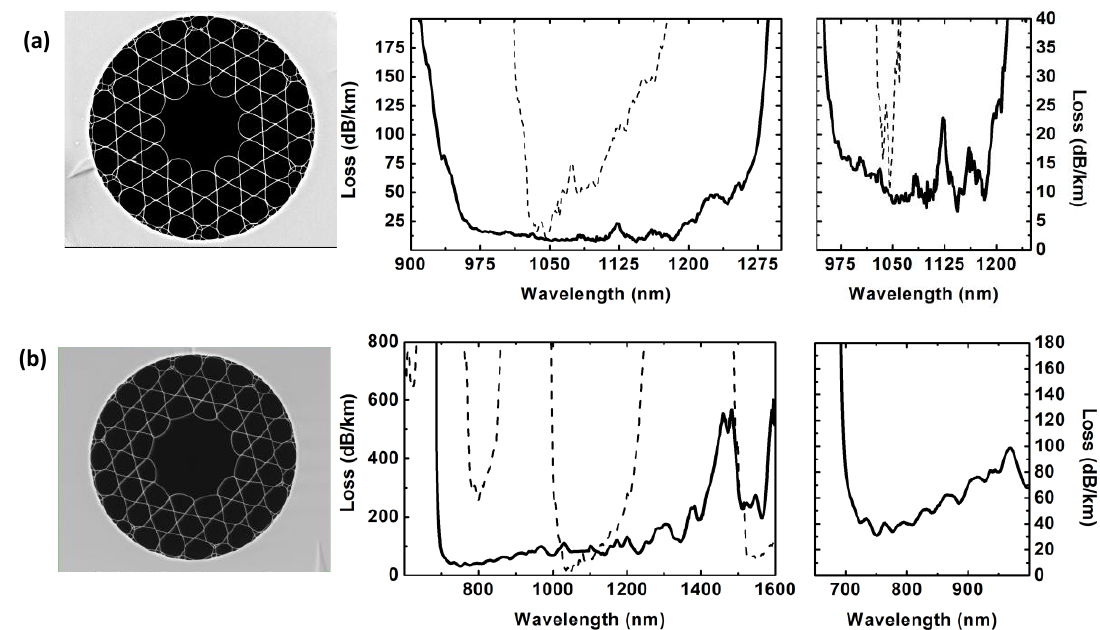
Figure 16. ( a , b ) Experimental loss spectrum of the loss record Kagome IC-HCPCF at an approximately 1030 nm spectral range and broadband-guiding Kagome IC-HCPCF (reprinted with permission from Reference [65], OSA, 2018).